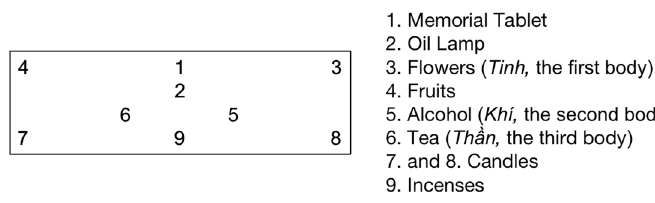
Figure 4. Ritual arrangement of the offering table for the dead ( Bàn Vong ).